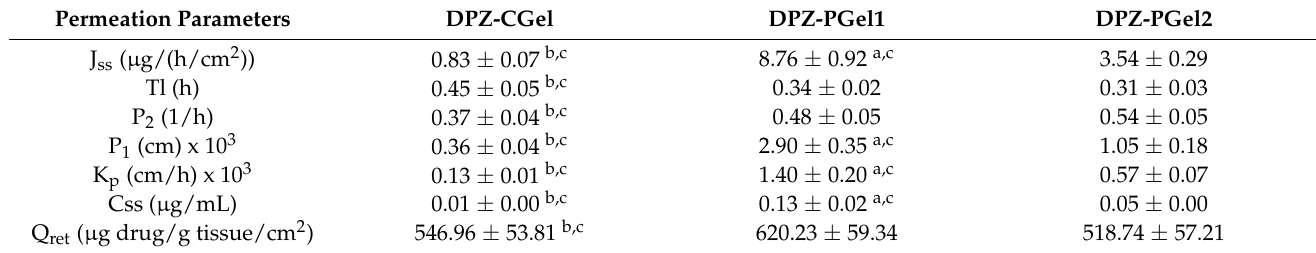
Table 5. Permeation parameters of donepezil (DPZ) formulations through nasal mucosa. Permeation Parameters